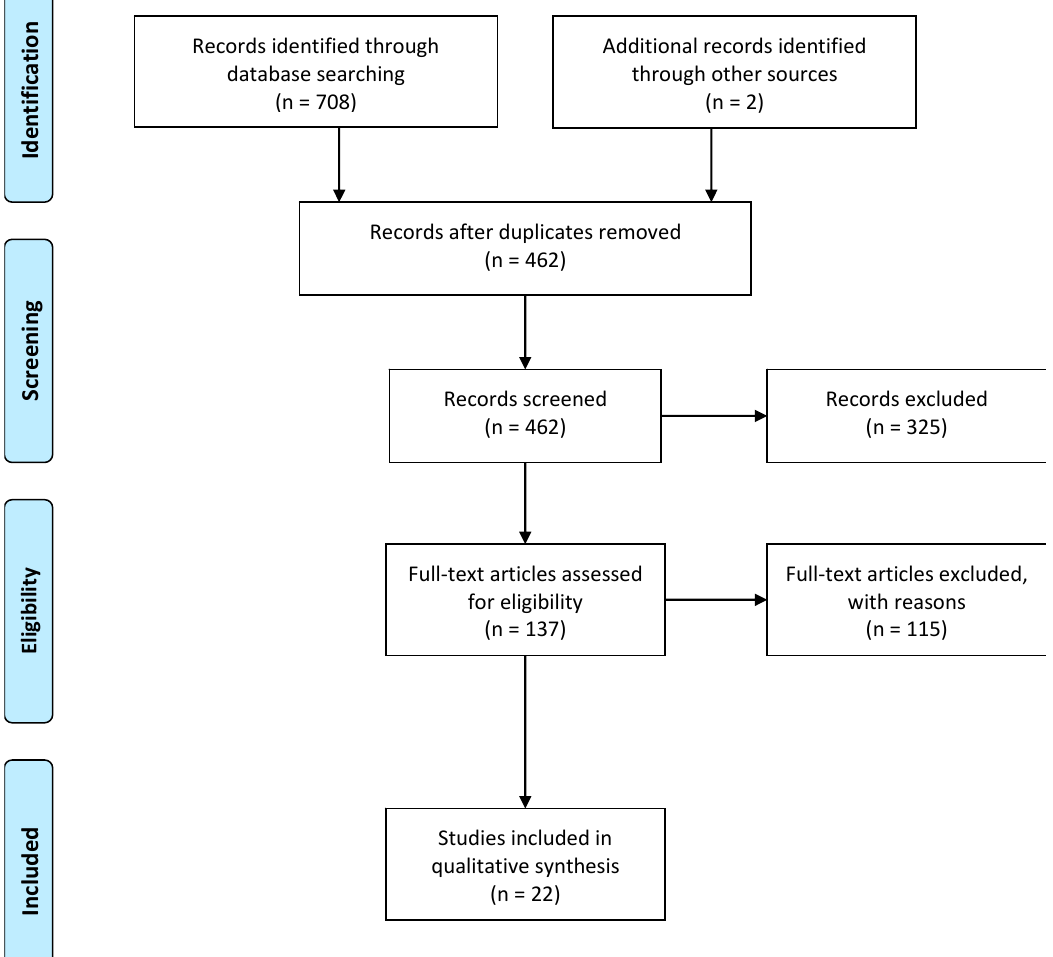
Figure 3. PRISMA flow diagram.